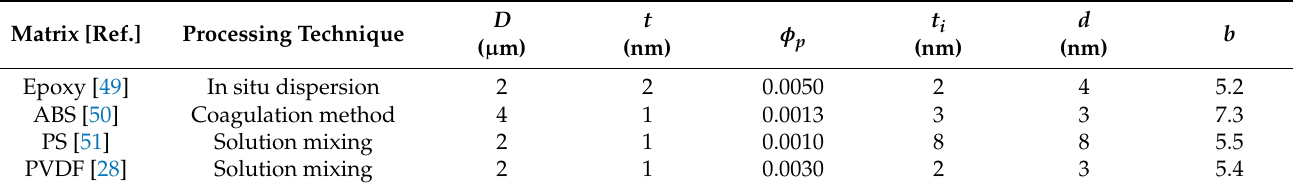
Table 1. Information of graphene–polymer